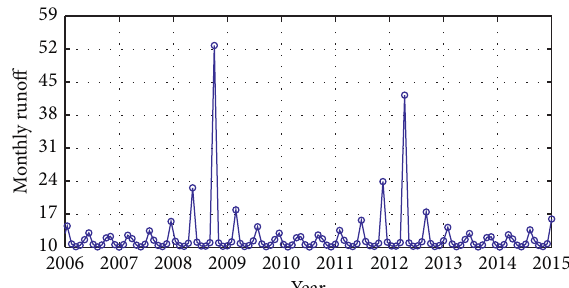
Figure 9: Simulation results of monthly runoff in Jianchang field (2006 ∼ 2015).